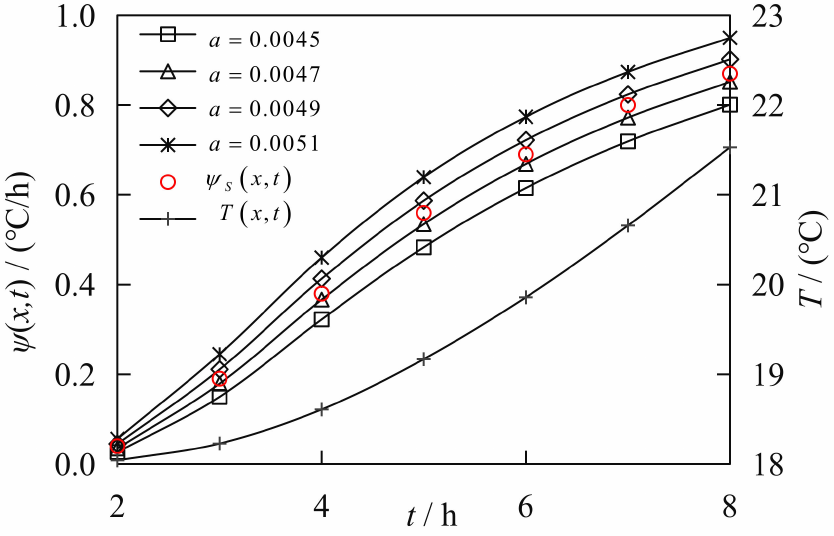
Figure 6. Curve-fitting for measured and theoretical curves of ψ ( x , t) to resolve a at x = 0.5 m.